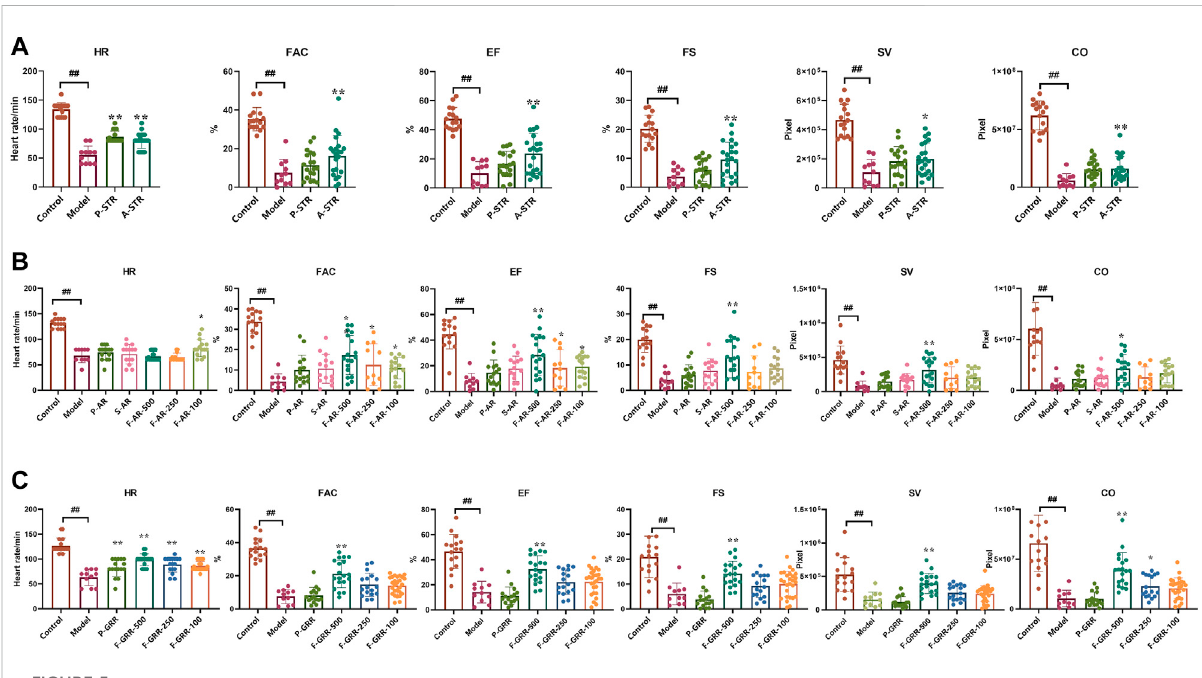
FIGURE 5 Thetherapeuticeffectsofthemaincomponentsofbotanicaldrugsonverapamil-inducedheartfailuremodelinzebra fi sh (A – C) Quanti fi cation ofcardiacfunctionin Tg(cmlc2:eGFP) zebra fi shlarvaetreatedwithmaincomponentsofSTR,ARandGRR.N ≥ 10. # p < 0.05vs . Control, ## p < 0.01vs . Control, * p < 0.05 vs . Model, ** p < 0.01 vs .